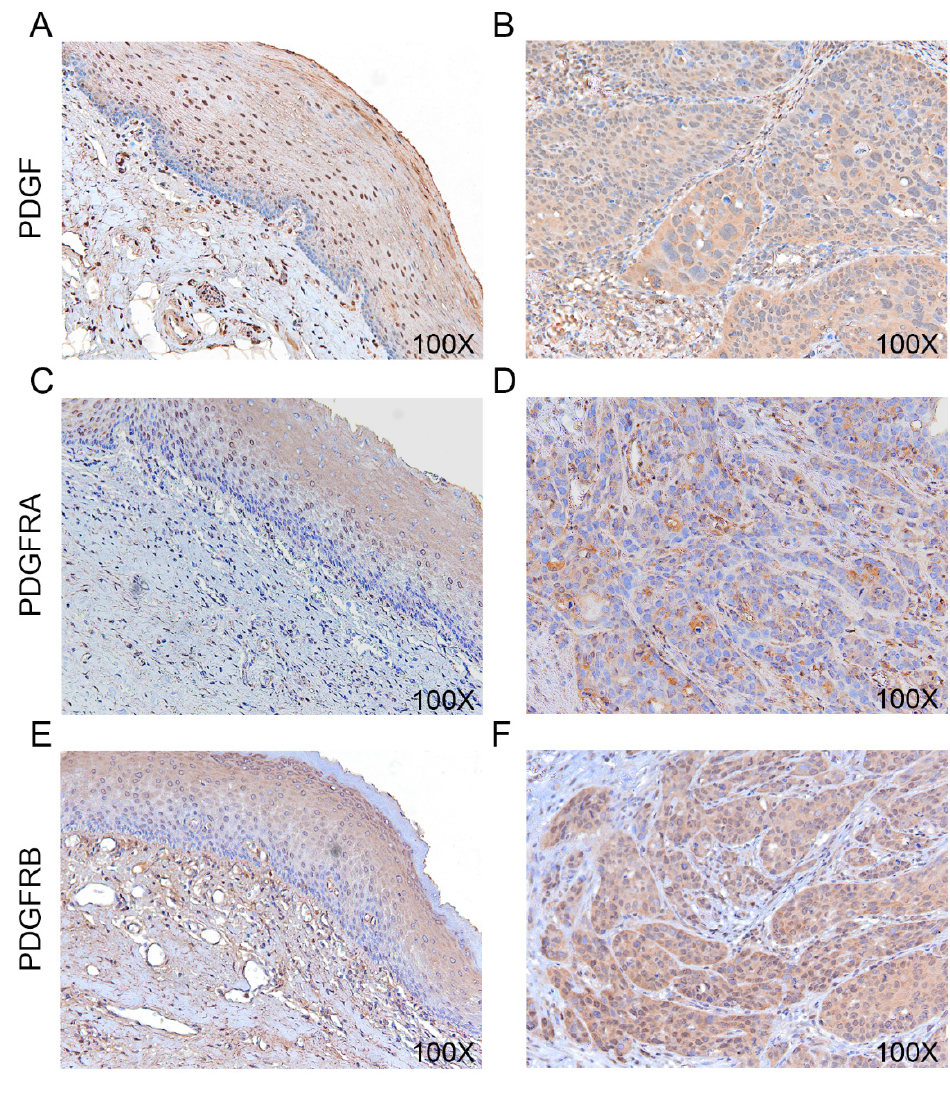
Figure 2. Immunohistochemical staining in OSCC. ( A , B ) Immunohistochemistry of PDGF in adjacent normal looking mucosa (A) and OSCC tumors (B). ( C , D ) PDGFRA immunoexpression. ( E , F ) PDGFRB immunoexpression. All IHC images were photographed at 100× magnification.